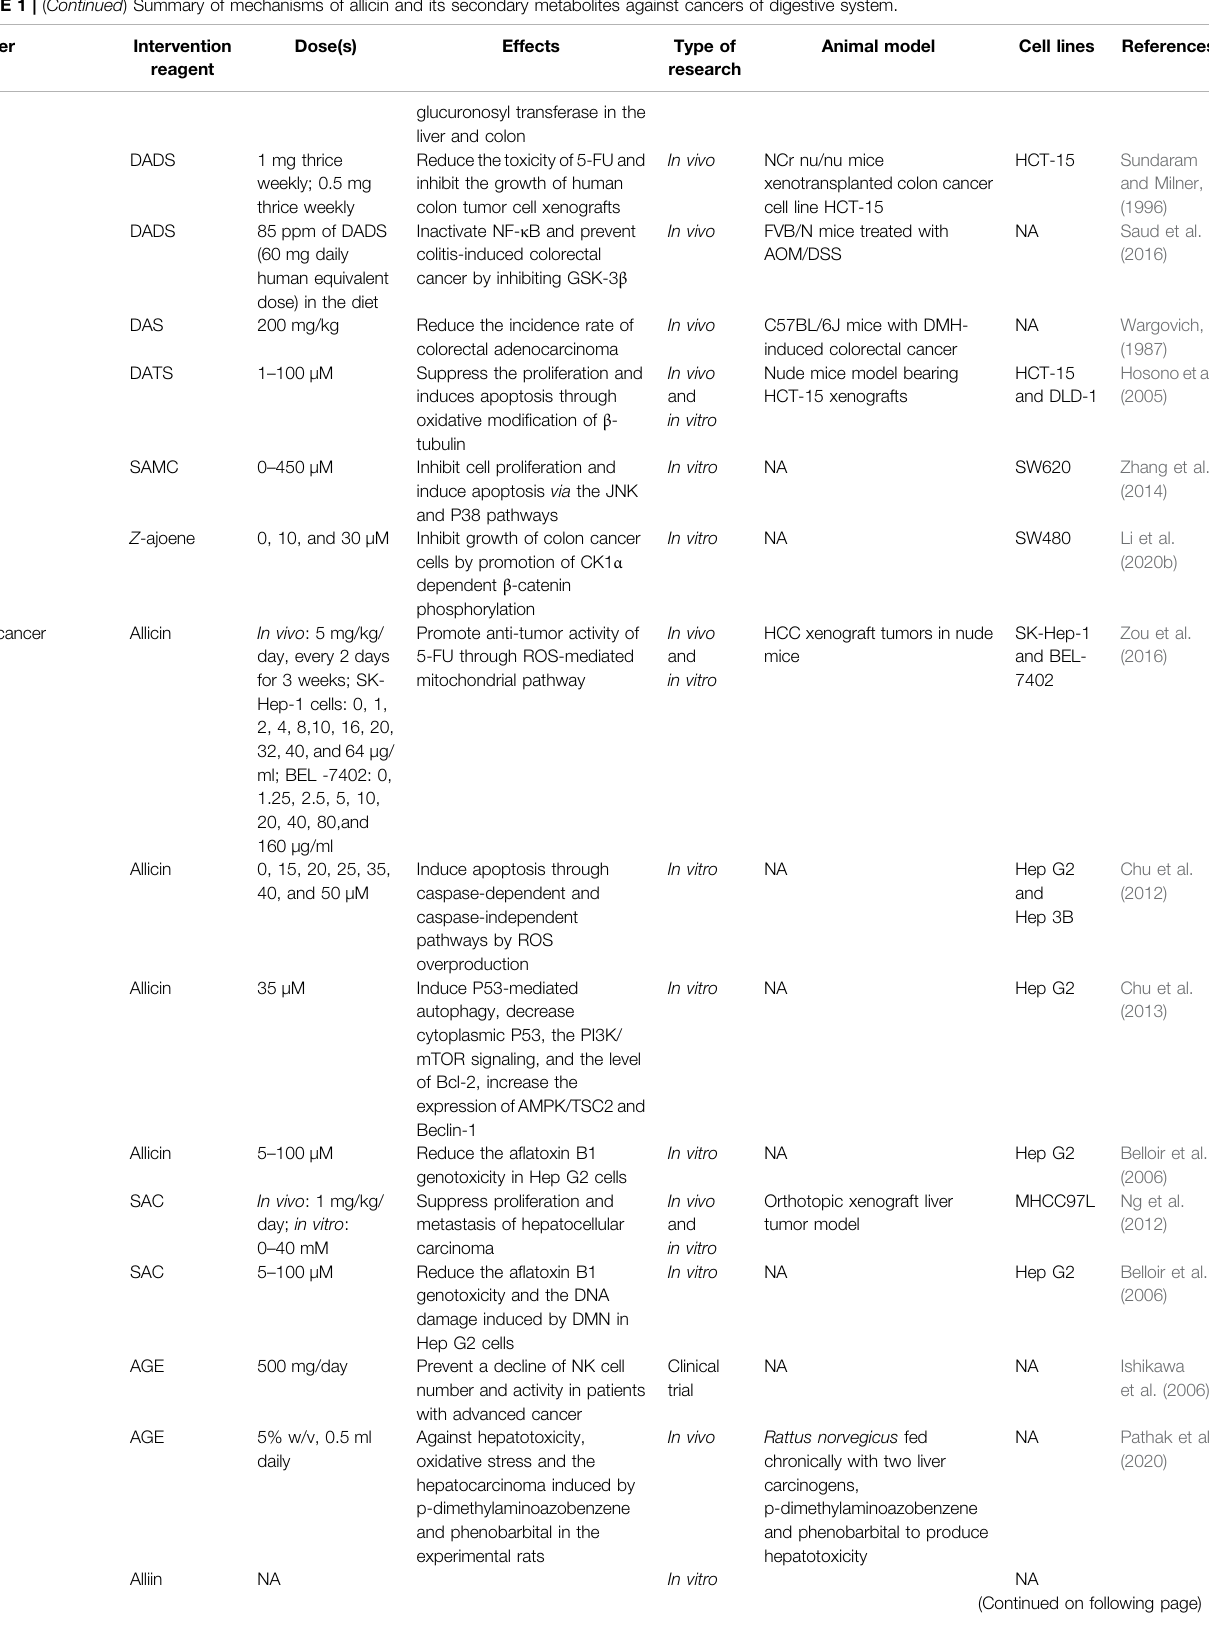
TABLE 1 | ( Continued ) Summary of mechanisms of allicin and its secondary metabolites against cancers of digestive system.